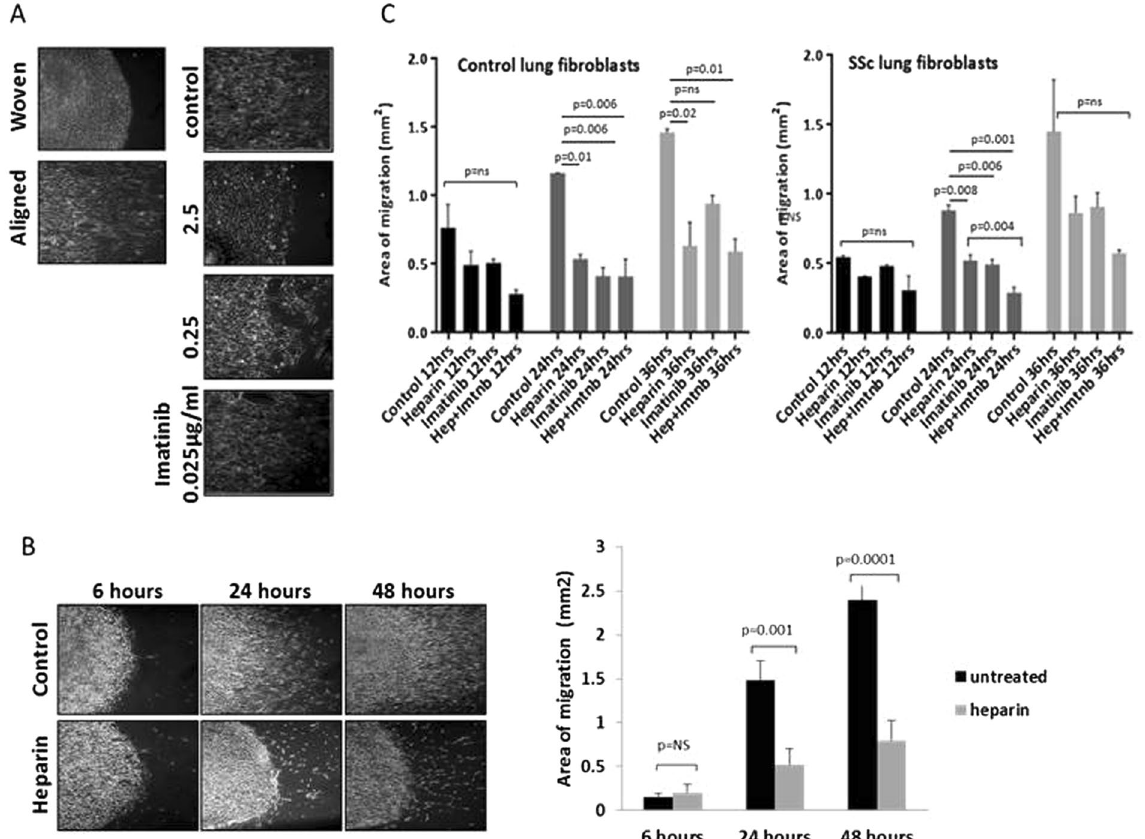
Figure 4. Effect of imatinib and heparin on lung fibroblast migration on aligned collagen. Initially the tyrosine kinase inhibitor imatinib, which blocks both PDGF receptor and c-Kit, was assessed for inhibition of aligned migration. Imatinib at 2.5 and 0.25 µ g/ml inhibited aligned migration ( A ). Unfractionated heparin was also assessed as a possible inhibitor of migration. SSc lung fibroblasts were cultured on aligned collagen with or without the addition of heparin at 50 μ g/mL to the media (DMEM plus 10% FCS). The migrating field of cells was quantified by ImageJ software, which outlined the migrating field of cells and then measured the area calibrated by the known dimensions of the 4 × axioscope fields. The addition of heparin inhibited cellular migration at 24 hours (p = 0.001) and 48 hours (p = 0.0001) ( B ). Combining heparin and imatinib in order to synergistically block growth factors as well as the receptor tyrosine kinases, was assessed. Combining both materials led to the lowest migration overall which was statistically significant for SSc cells ( C ). Control fibroblasts showed similar